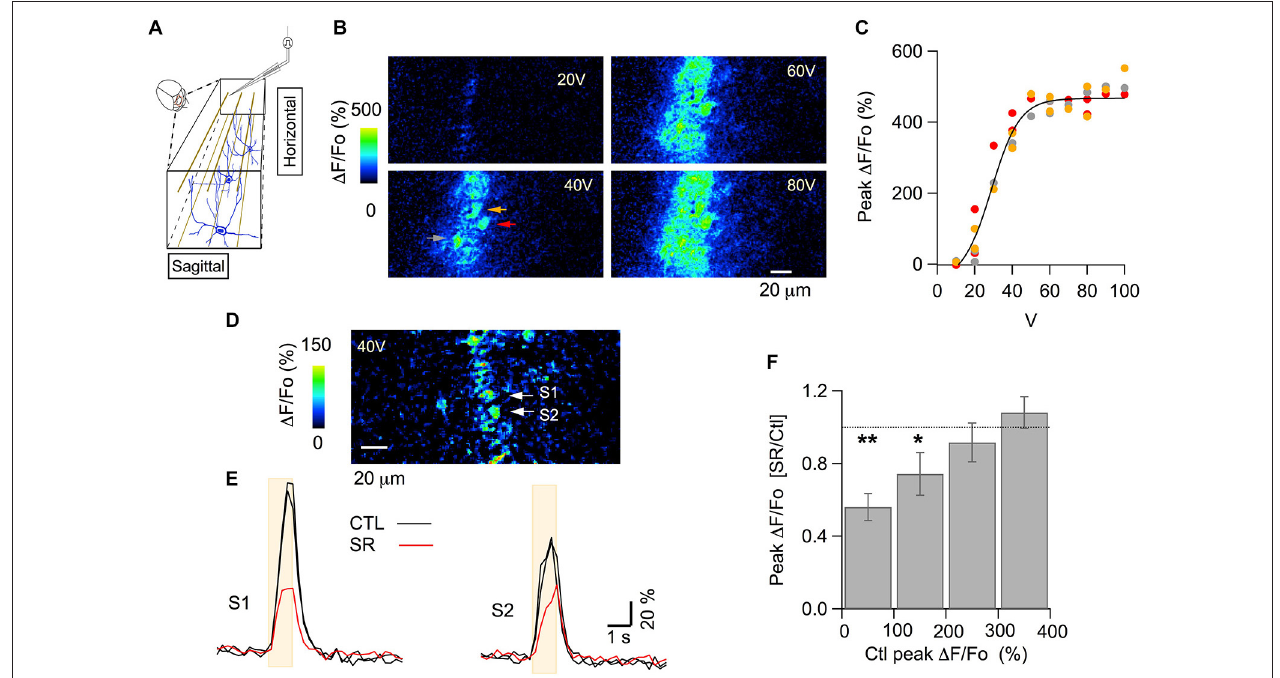
specific blocker SR95531 (75 µ M) to the solution bathing the craniotomy (red trace). Each trace is the average of three consecutive runs. To illustrate the signal stability prior to drug application, control runs were averaged over two control periods. The beige boxes denote the time of extracellular stimulation. (F) The effect of SR95531 depends on the initial amplitude of the PF-evoked signal. Data was pooled from 37 somata recorded from seven mice. Ratios of peak ∆ F/Fo in control over drug were grouped by bins according to the peak ∆ F/Fo value in the control runs. Values for each soma were averaged over three consecutive runs for the control period and for the same number of runs taken 30–50 min after drug application. Error bars are mean ± SEM. Number of cells and p value for paired Student’s t -test were: 9 and 0.002 for the first bin; 11 and 0.05 for the second bin; 9 and 0.47 for the third bin; 8 and 0.31 for the fourth bin. *denotes groups with p ≤ 0.05; **groups with p ≤ 0.01. In six of these experiments, comparison of the F 910 /F 810 values (see “Materials and Methods” Section) in control and after addition of SR95531 yielded no significant difference ( p value for paired Student’s t -test: 0.34) suggesting that no significant changes in basal Ca i levels